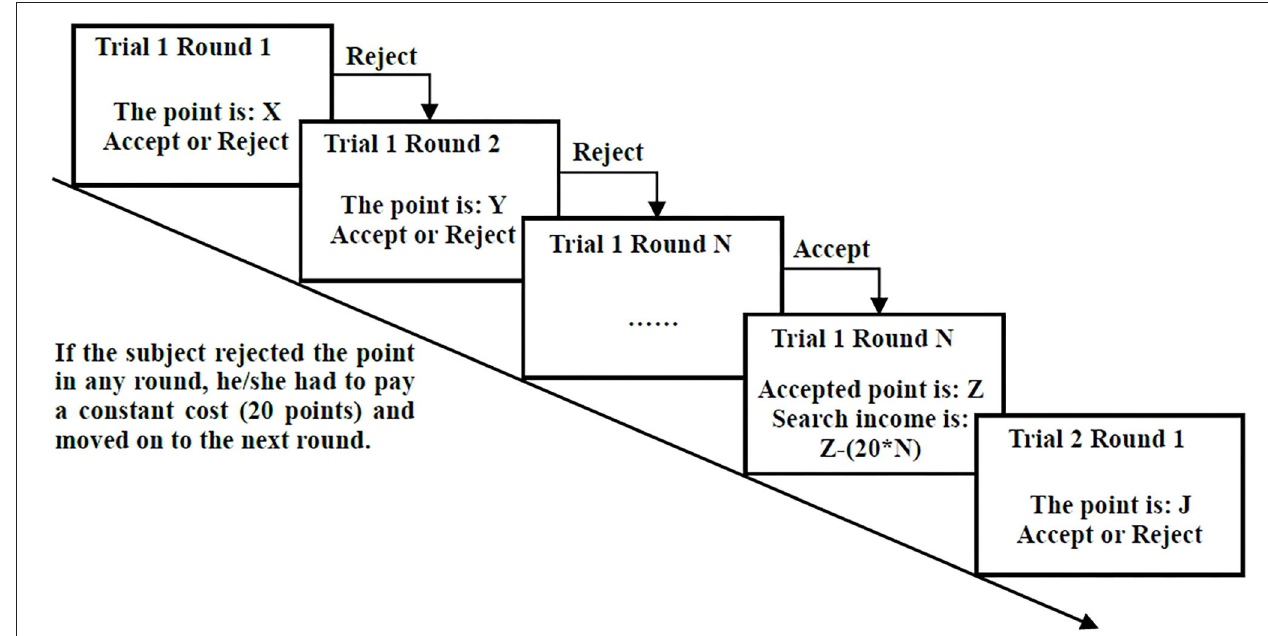
FIGURE 1 | Search task.